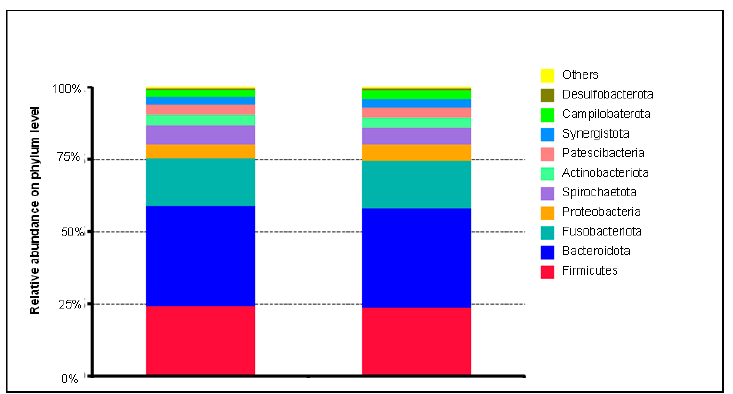
Figure 1. Microbial community composition at the phylum level comparing CV patients without and with a combined CV endpoint according to the MACCE criteria in the 3-year follow-up.